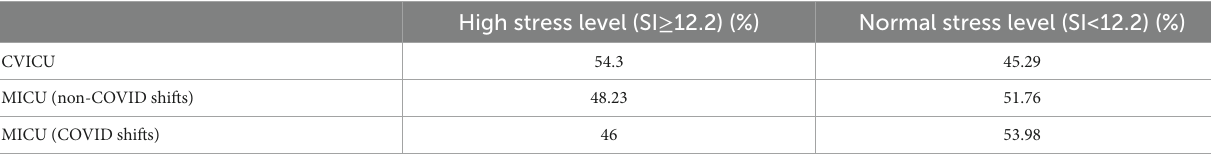
TABLE 3 Percent time spent in high, normal, and low stress levels by the participants.